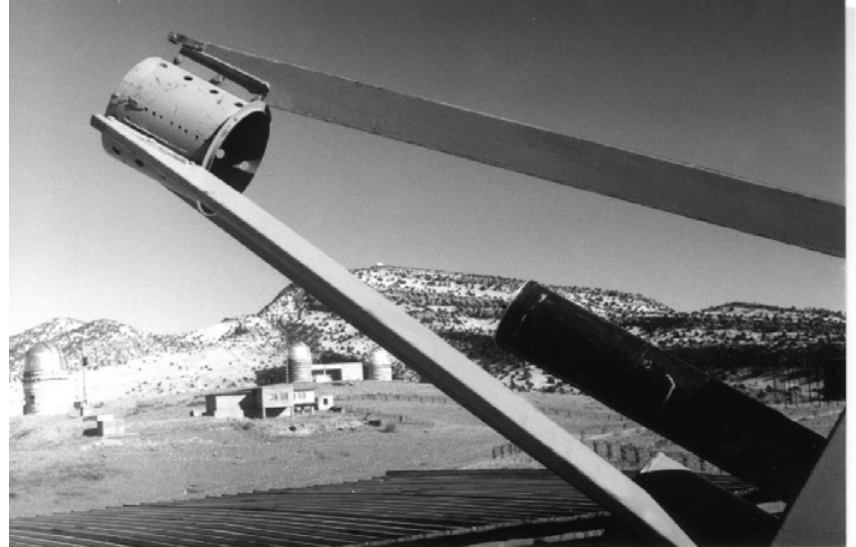
Fig. 1. The west part of the Mt. Dushak-Erekdag Observatory: the dome for 2 m telescope, two domes for two 0.5 m dual-tube telescopes, some other buildings for service. In the foreground is seen the tubeless construction of Odessa 0.8 m telescope and the sliding roof of the